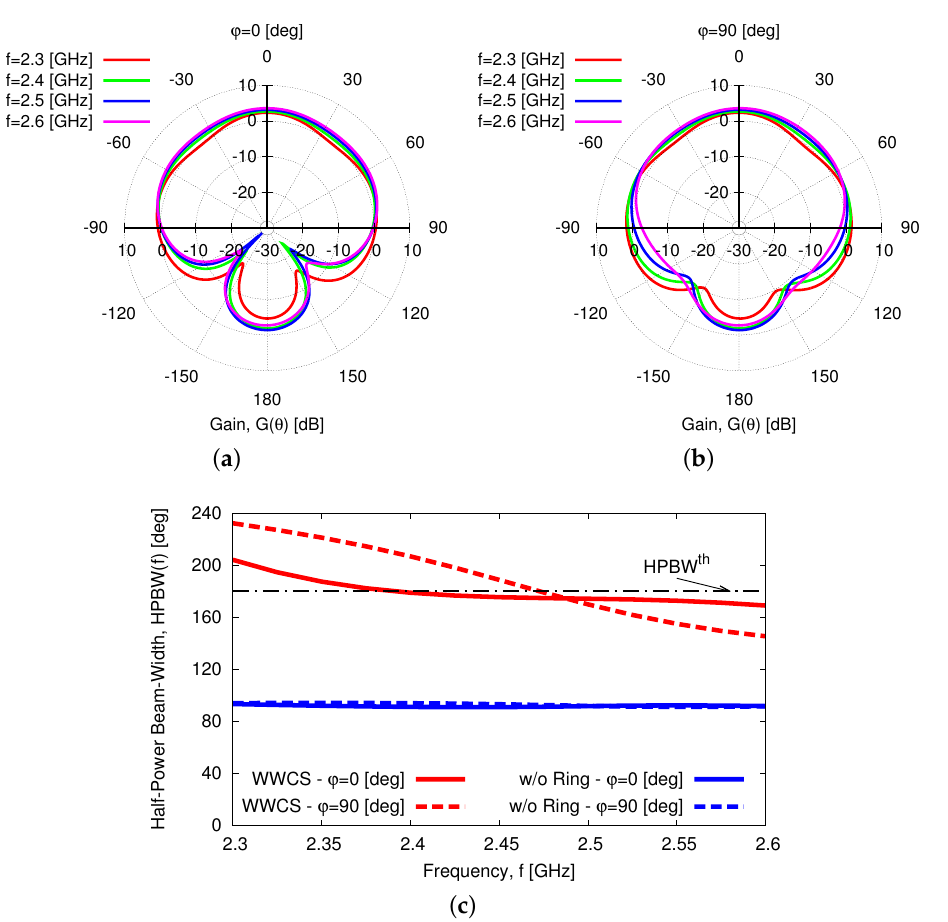
Figure 7. Numerical Assessment ( [ f min , f max ] = [ 2.3, 2.6 ] [GHz])—Plot of ( a , b ) the gain pattern at different frequencies in the elevation planes ( a ) ϕ = 0 [deg] and ( b ) ϕ = 90 [deg] and of ( c ) the half-power beamwidth, HPBW ( f , ϕ ) on both planes, comparing the synthesized WWCS radiator with a planar layout obtained by removing the top layer ( (cid:96) 3 —Figure 1) hosting the parasitic ring. The optimized WWCS layout exhibits the desired LHCP operation and is pointed out by both the co-polar, G LHCP ( f 0 , θ , ϕ ) , and the cross-polar, G RHCP ( f 0 , θ , ϕ ) , gain patterns in Figure 5, where it can be clearly observed that G ( f 0 , θ , ϕ ) ≈ G LHCP ( f 0 , θ , ϕ ) and G LHCP ( f 0 , θ , ϕ ) (cid:29) G RHCP ( f 0 , θ , ϕ ) for 0 ≤ θ ≤ 90 [deg] with broadside AR and XPD equal to AR ( f 0 , θ = 0, ϕ = 0 ) = 3.2 [dB] and XPD ( f 0 , θ = 0, ϕ = 0 ) = 15 [dB], respectively. Moreover, such a good polarization purity is kept almost unaltered in the complete radiating upper semi-sphere with the exception of the elevation angles close to the antenna end-fire as illustrated by the 2D maps of AR ( f 0 , θ , ϕ ) [Figure 8a] and XPD ( f 0 , θ , ϕ ) [Figure 8c] as well as by the corresponding thresholded pictures aimed at highlighting the fulfilment of the design requirements [Figure 8b,d]. It is worth remarking that the slight degradation of both AR and XPD appears only in the most challenging region (i.e., θ (cid:39) 90 [deg]) and is possibly due to the spurious radiation by the slot along the directions of its major arms (i.e., ϕ = 135 [deg] and ϕ = 315 [deg]—Figure 8 and Figure